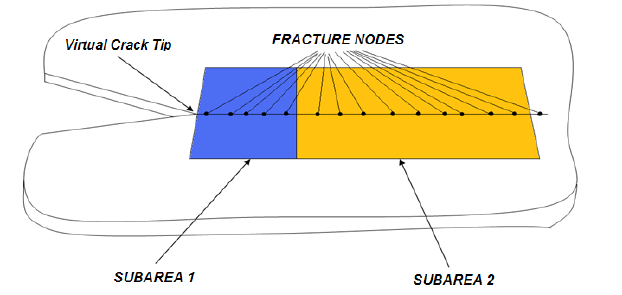
Figura 6: R appresentazione dell’area di campionamento mobile.